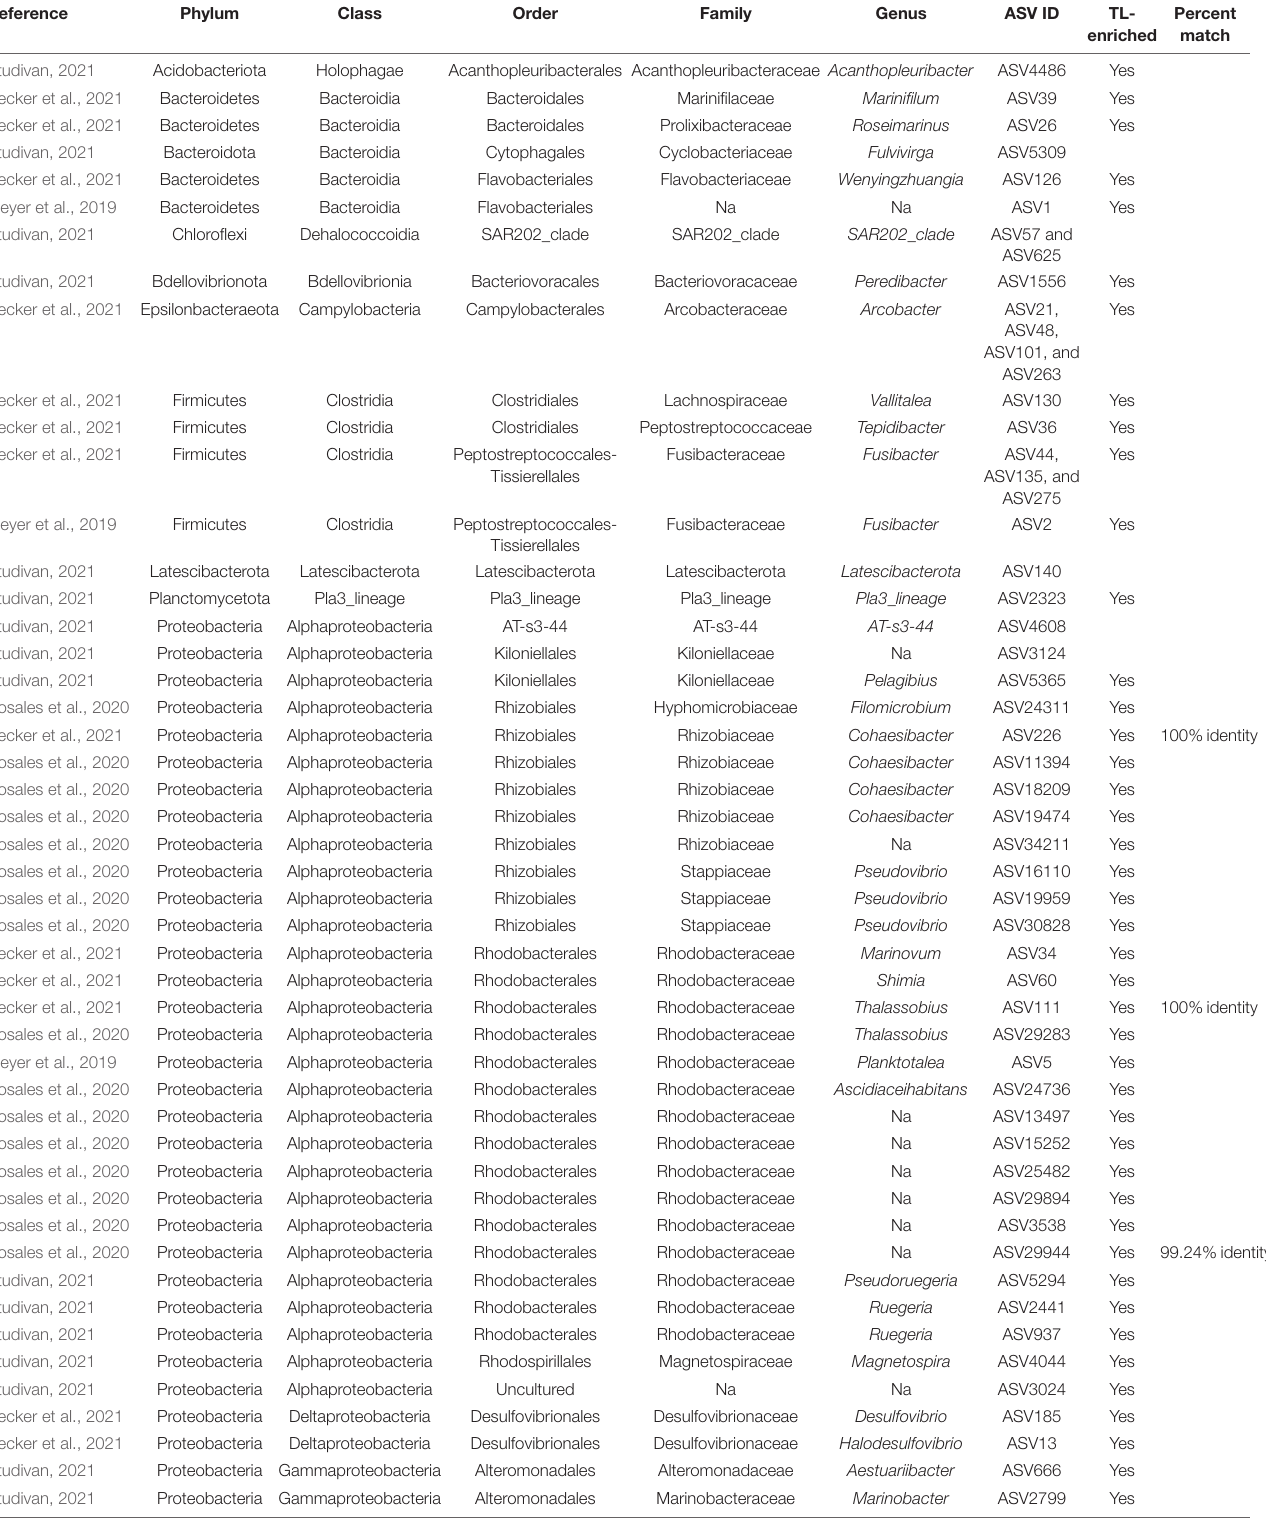
TABLE 3 | Differentially abundant ASVs identified across sediment samples by coral condition in our experiment † , as well as those found in association with SCTLD from previous